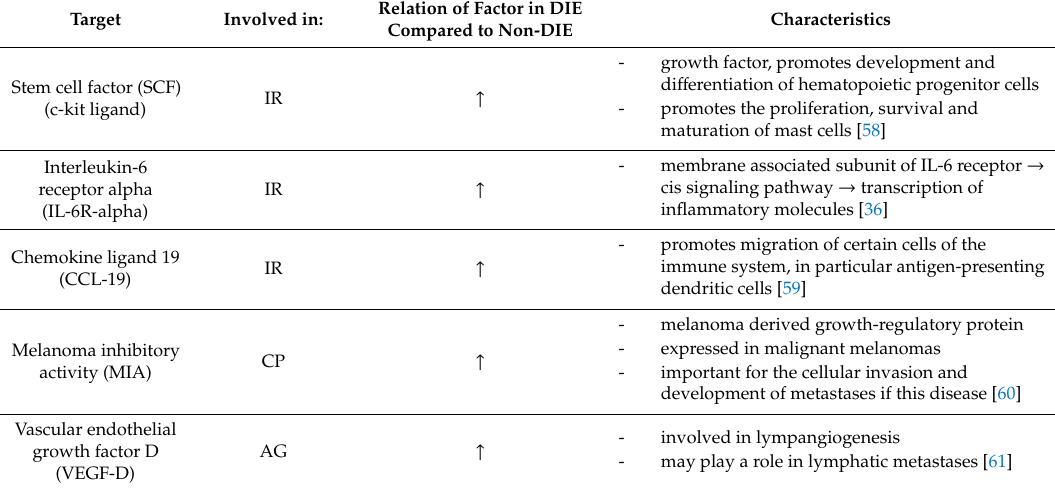
Table 5. Summary of the characteristics of factors that are significantly enriched in patients with DIE compared to endometriosis patients without